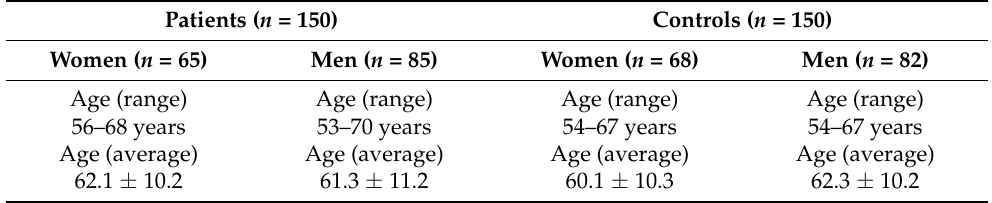
Table 2. The number and age of the patients and the control group who underwent miRNA